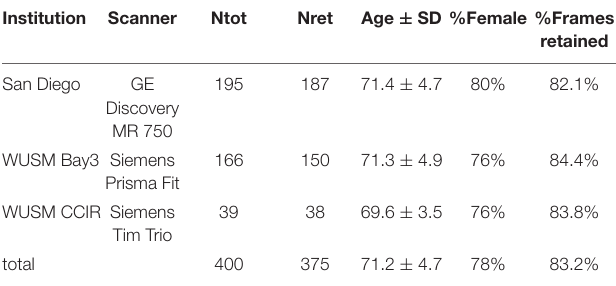
TABLE 2 | MEDEX participants broken down by